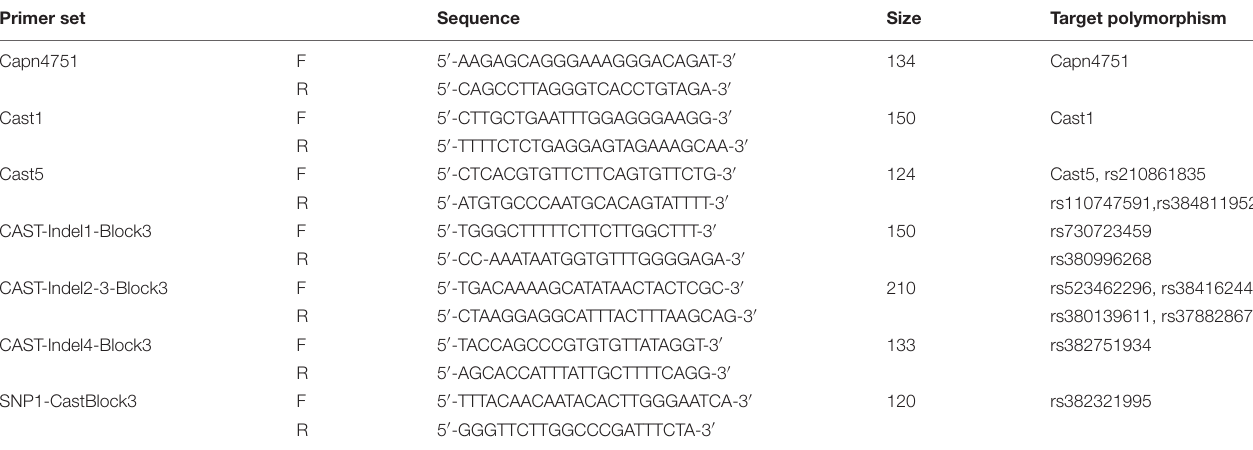
TABLE 1 | Primer sets for µ -calpain and calpastatin polymorphisms genotyped using high resolution melt analysis. Primer set Sequence Size Target